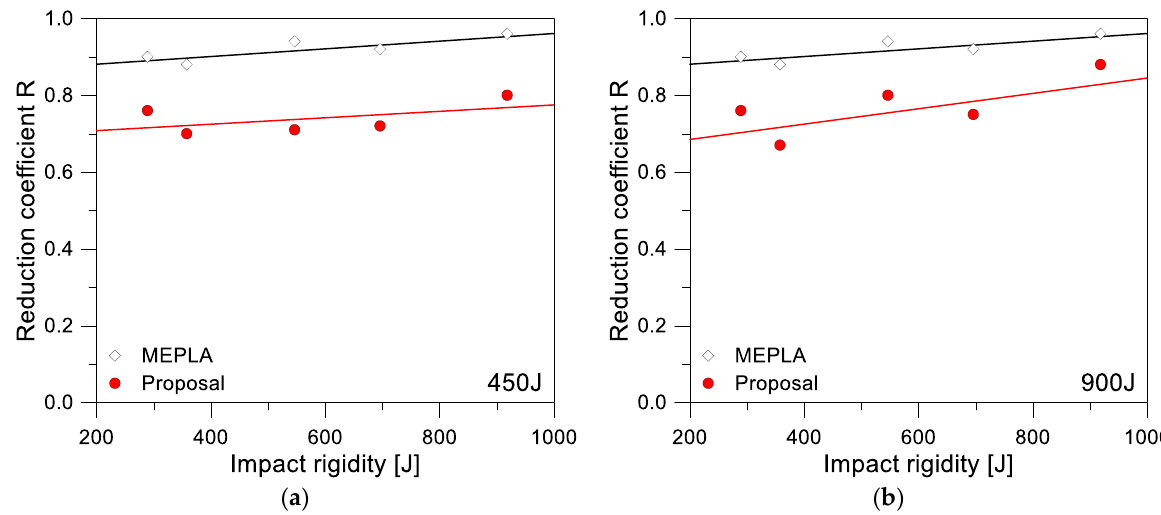
Figure 22. Calculated reduction coefficients R as a function of the impact rigidity, with E imp equal to ( a ) 450 J or ( b ) 900 J.